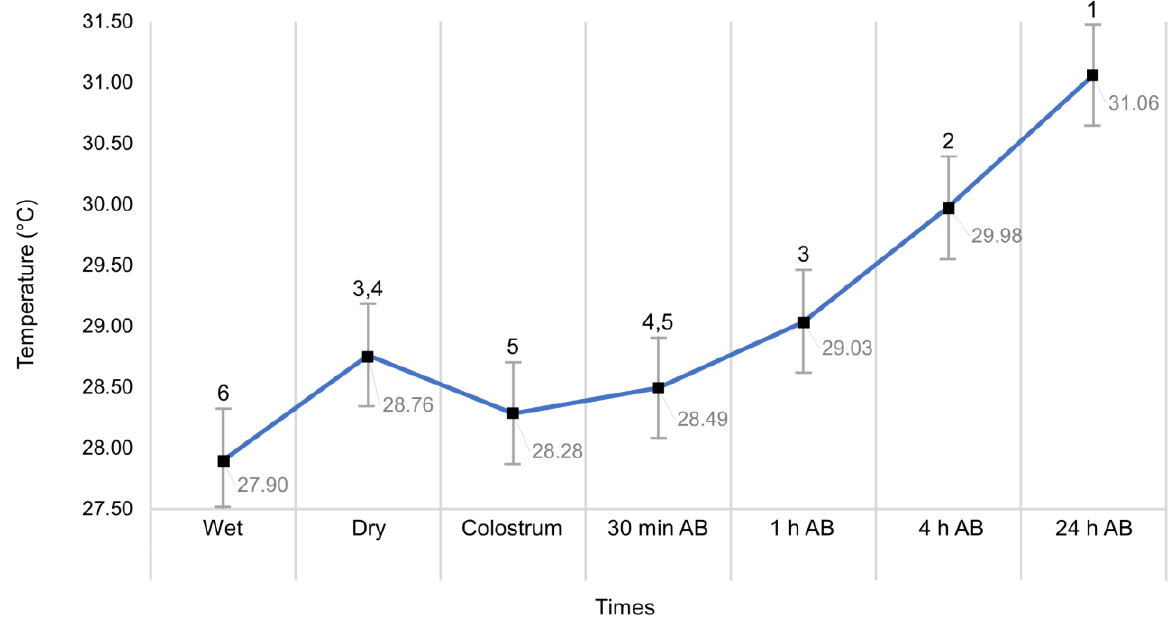
Figure 3. Neonatal average temperature values throughout the experimental period regardless of the surface region or dam’s weight. Means ± standard errors. Different numbers (1,2,3,4,5,6) indicate significant differences between times in the same dam’s weight group. AB: after birth.